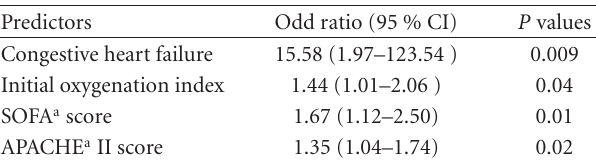
Table 4: Predictors of ventilator dependence in patients with ventilator-associated pneumonia by multivariate logistic regression analysis.